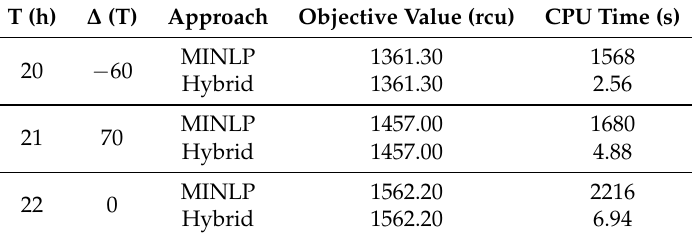
Figure 10. Prediction of required number of time points. Table 8. Performance comparison for BR-S